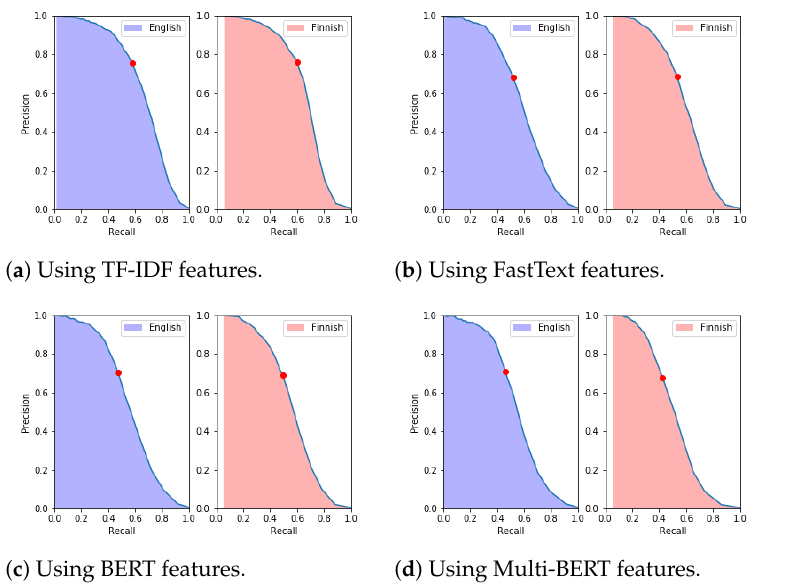
Figure 7. Precision-Recall curves obtained from evaluating the combination of the ML-RF model with the feature extraction methods. The red dots represent the point where the corresponding maximum F1 score was measured for every